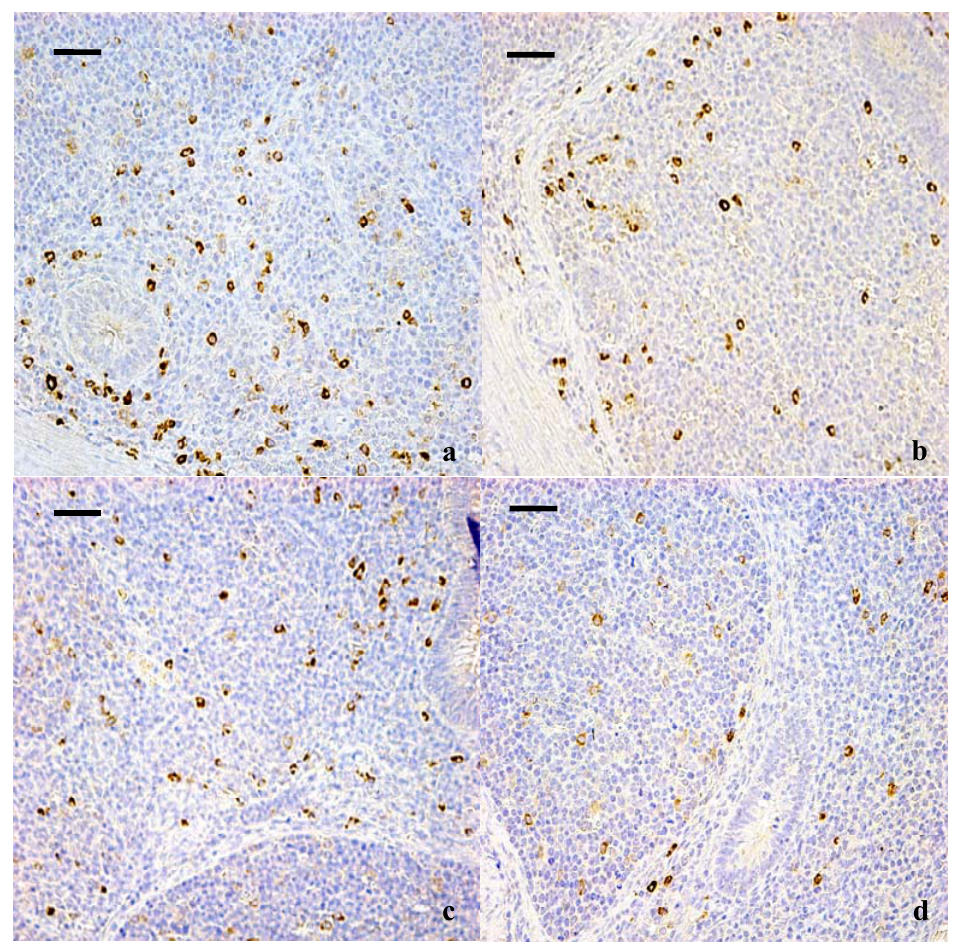
Figure 2. IgA + B cells in the diffuse lymphoid tissues and lymphoid follicles of cecal tonsil at 42 days of age. ( a ) The cecal tonsil in control group (400×, bar = 50 μ m); ( b ) The cecal tonsil in high fluorine group I. The quantities of IgA + B cells were not significantly decreased (400×, bar = 50 μ m); ( c ) The cecal tonsil in high fluorine group II. The quantities of IgA + B cells were decreased (400×, bar = 50 μ m); ( d ) The cecal tonsil in high fluorine